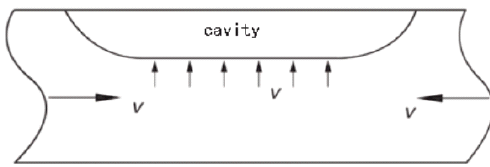
Figure 7. Force analysis of the cavity collapse process in a large-diameter tube.